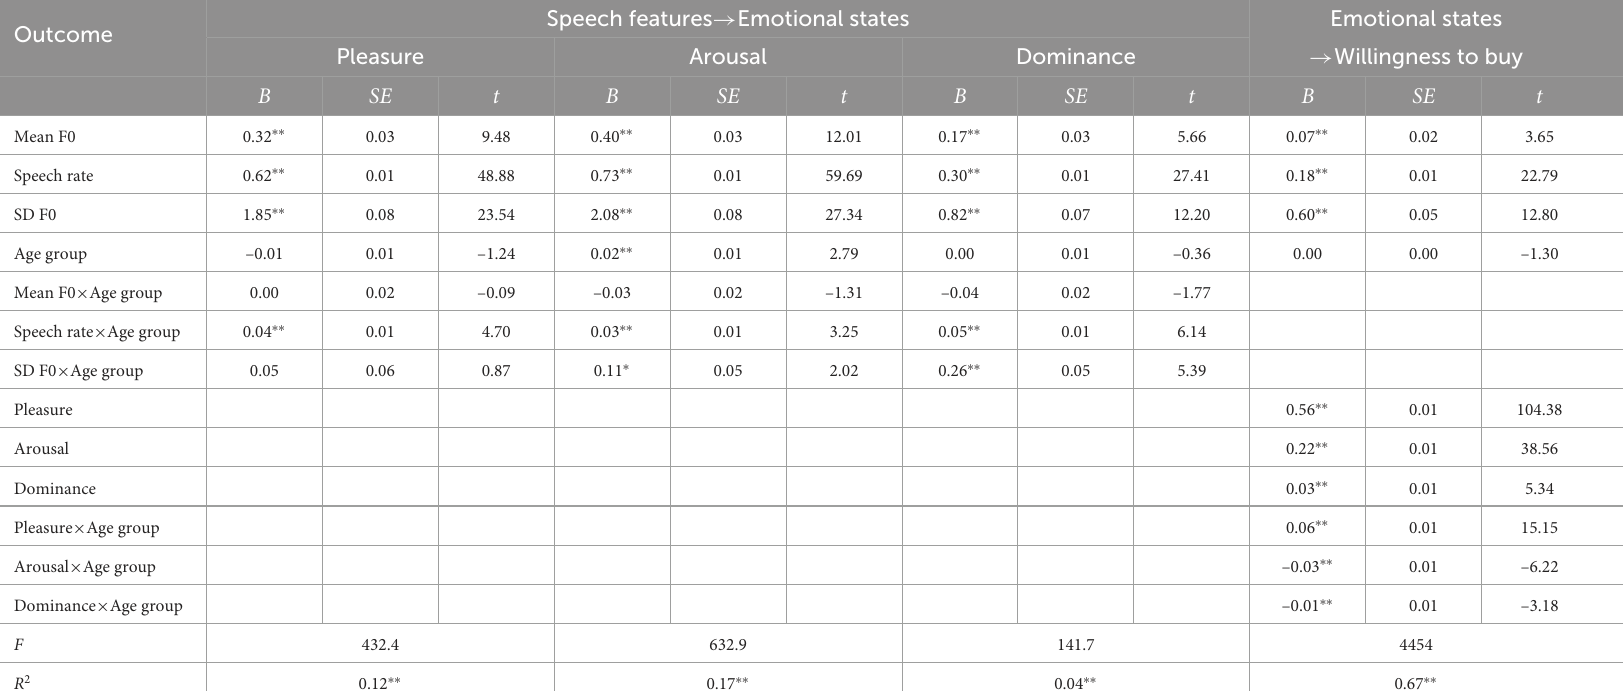
TABLE 7 Results of moderated mediation analysis for listeners’